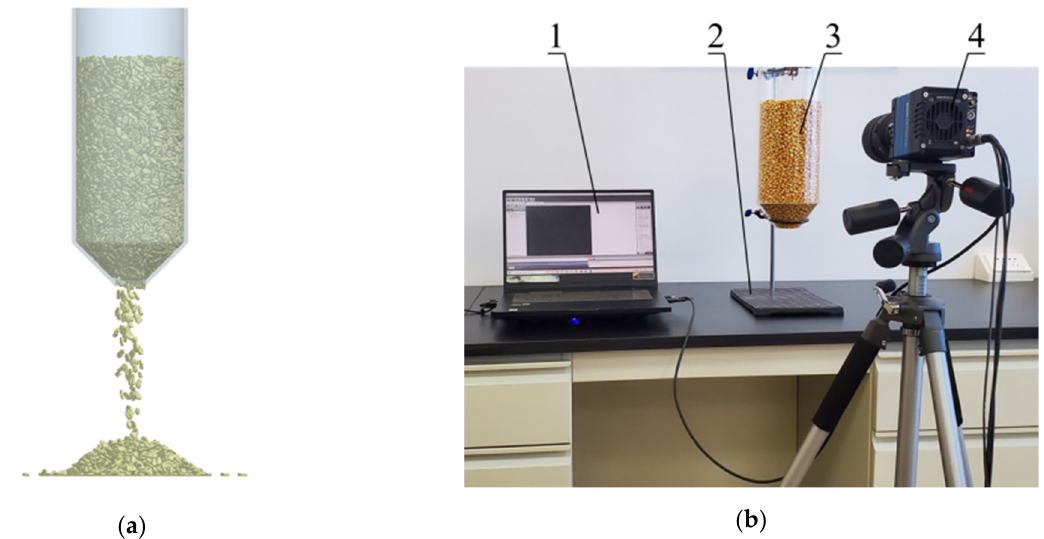
Figure 5. Simulation of corn grain flow and high-speed camera test: ( a ) EDEM simulation; ( b ) high-speed camera test. 1. PC; 2. Bench; 3. Vertical grain cylinder model; 4. High-speed camera.